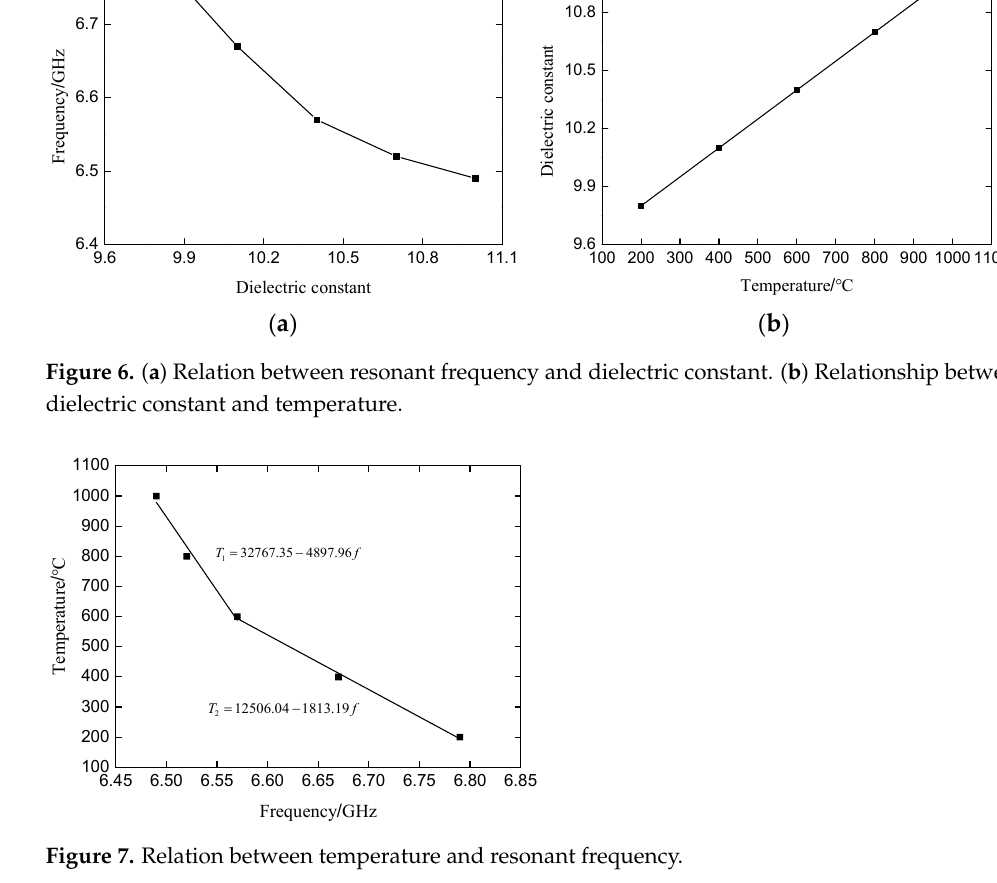
Figure 7. Relation between temperature and resonant frequency.